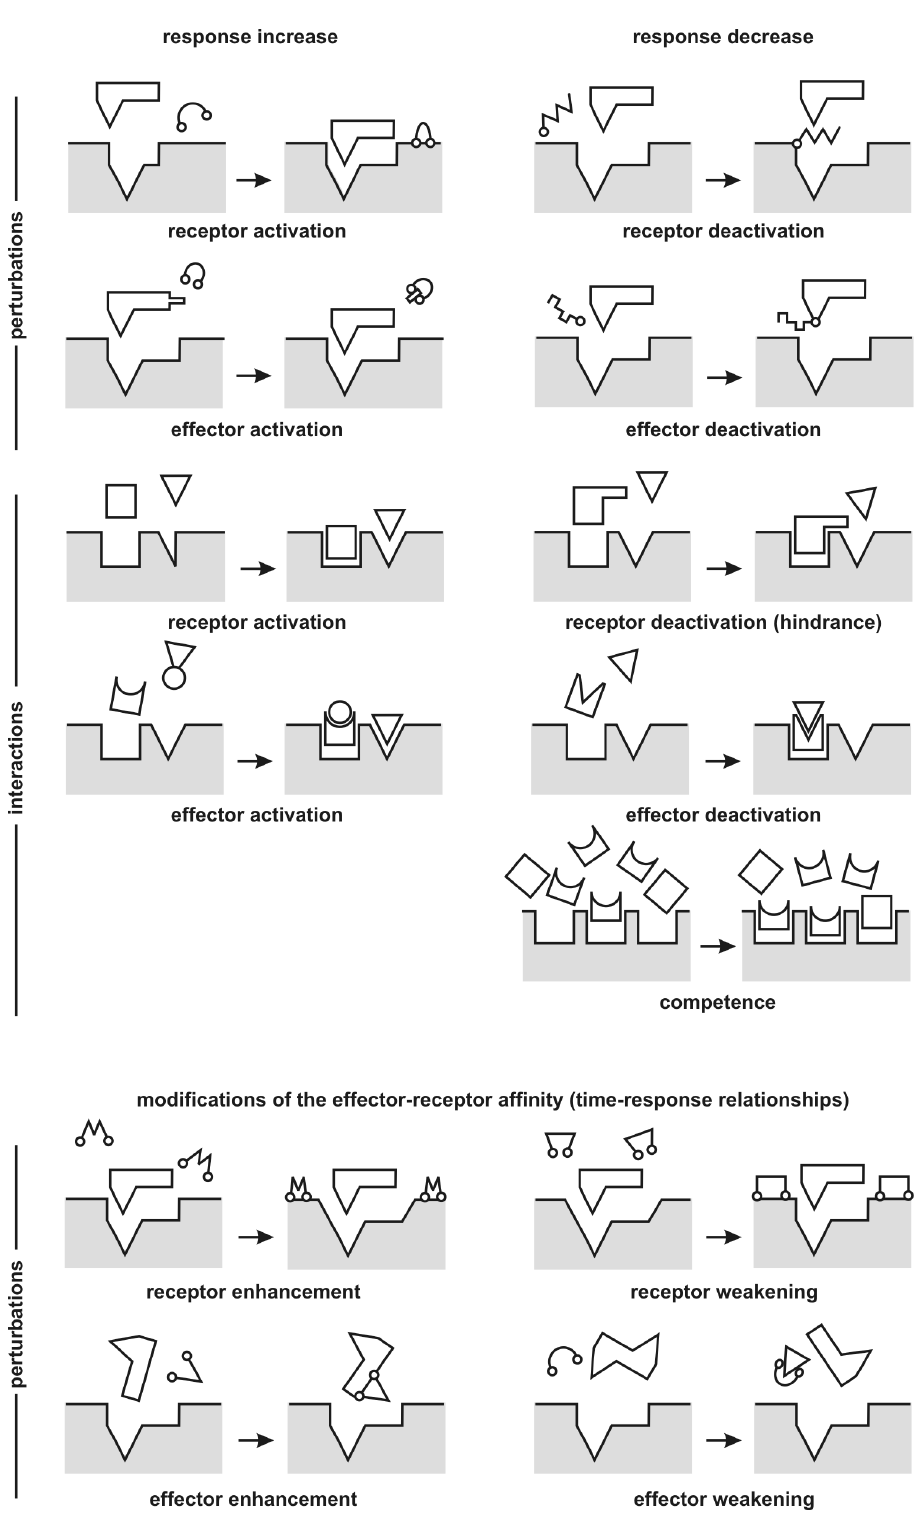
Figure 3. Some key-lock analogies. Possible response modifications involving alterations of the effective dose or the number of active receptors are illustrated (see Table 1). Notice that the alterations of the effector-receptor affinity (for simplicity reasons only perturbations are illustrated) do not modify the response to a given dose, but the response to a given time.